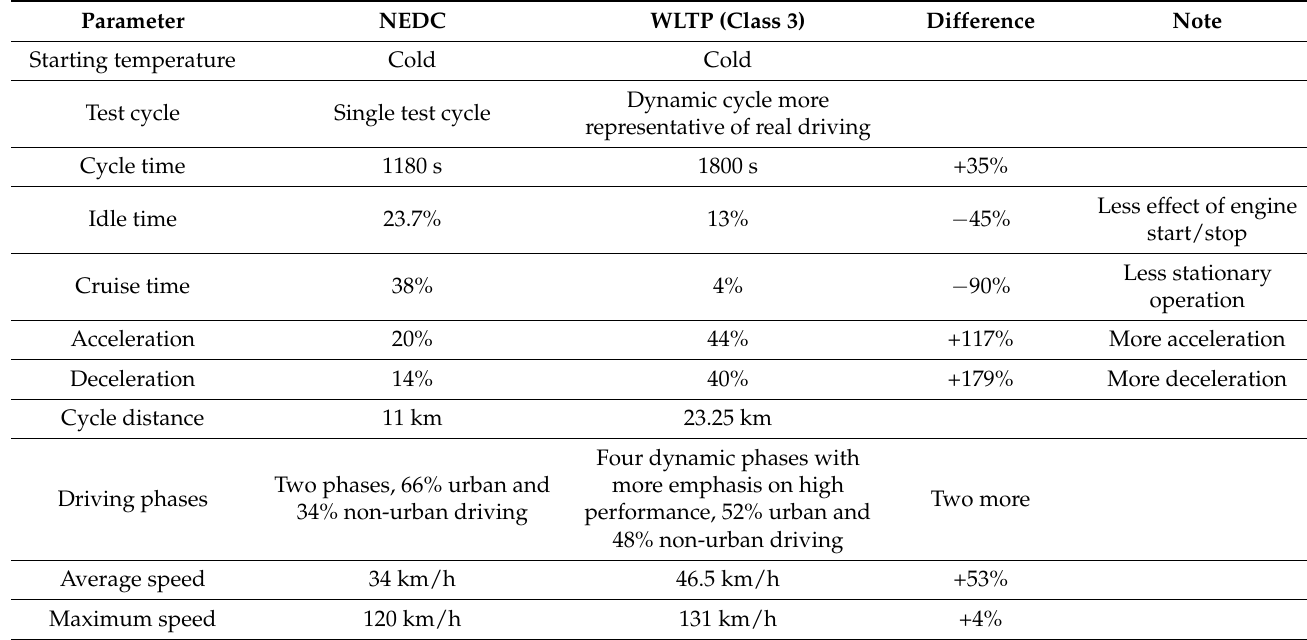
Figure 4. NEDC and World Harmonized Light-Duty Vehicle Test Cycle (WLTC) class 3 driving profiles over time [129] (Reproduced with permission from D. Tsokolis et al. [129], Applied Energy; published by Elsevier Ltd., 2016). Table 4. Main differences between NEDC and Worldwide Harmonized Light Vehicle Test Procedure (WLTP) [122,124,125,